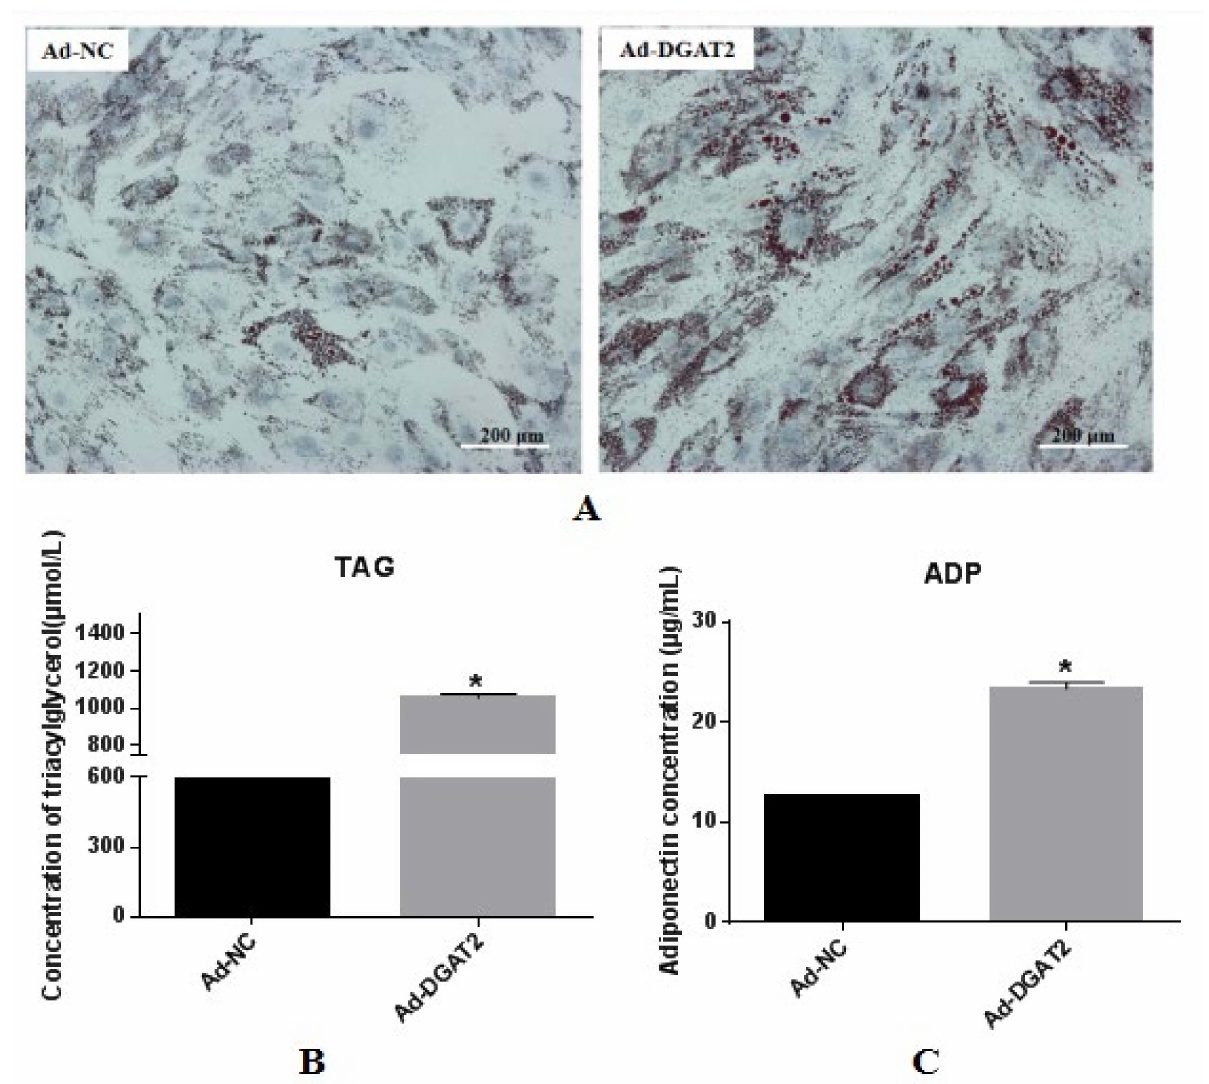
Figure 3. Overexpression of DGAT2 promotes BSCs lipid droplet accumulation, cellular TAG con- centration, and adiponectin content in the medium. ( A ) Oil red O staining (scale bar: 200 µ m). ( B ) Cellular TAG content after overexpression of DGAT2. ( C ) ADP content in the medium after overexpression of DGAT2. Values are presented as means ± SEM from three individual cultures. * p <